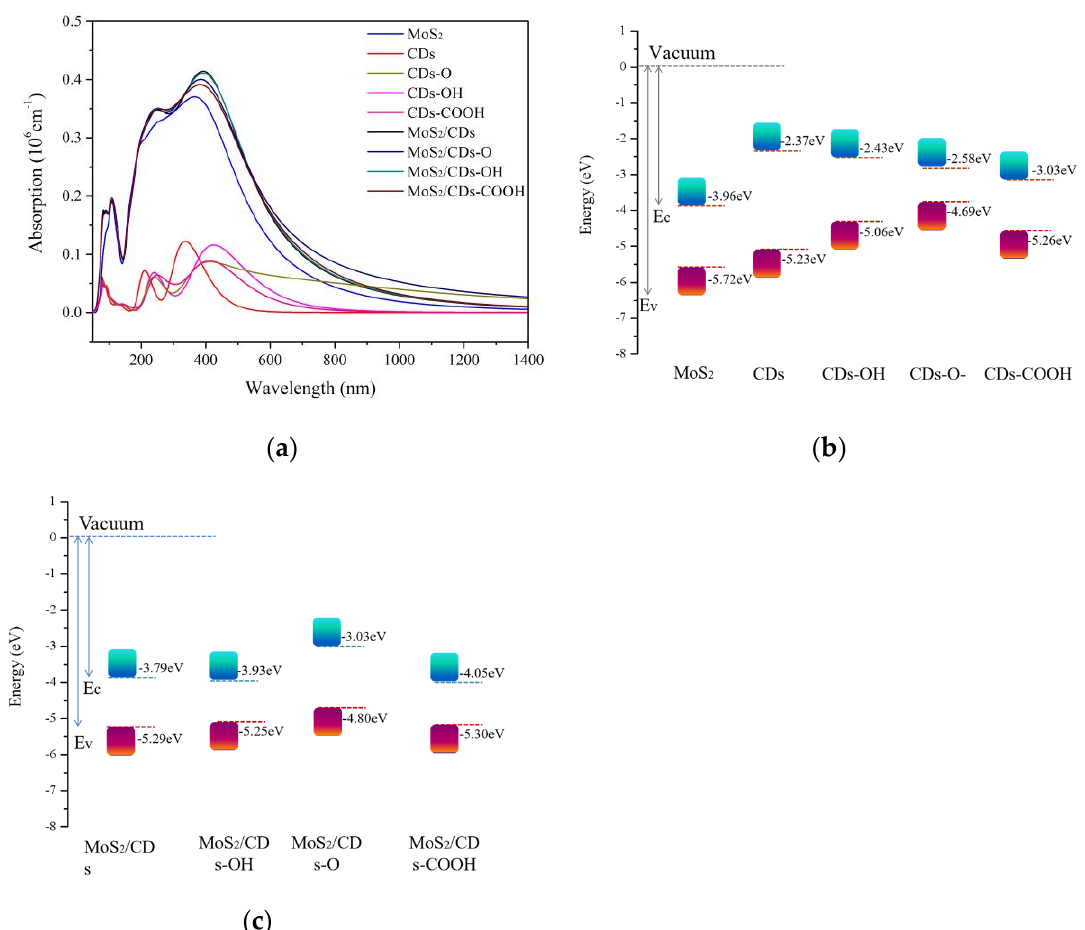
Figure 6. Optical absorption spectra ( a ); the calculated valence band maximum (VBM) and conduction band minimum (CBM) of MoS 2 , CDs, CDs-OH, CDs-O, and CDs-COOH; ( b ) and MoS 2 /CDs-T ( c ).